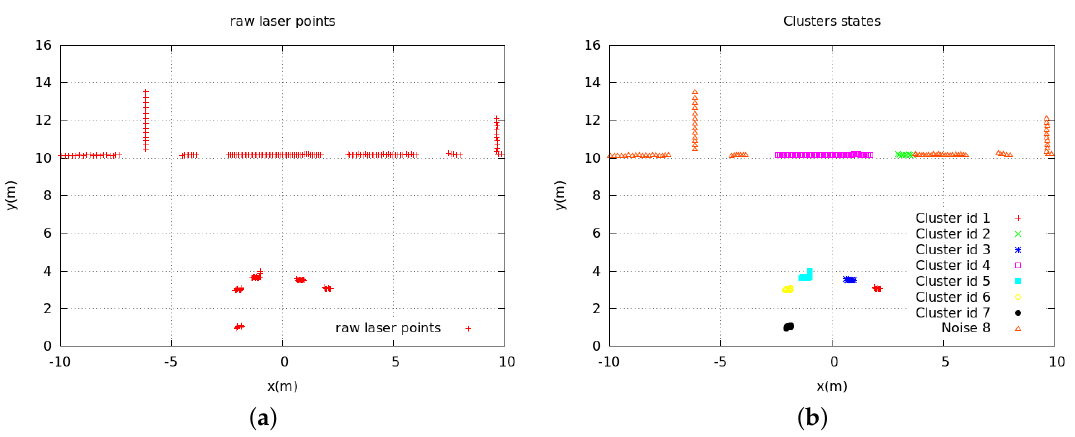
Figure 2. Clustering results. ( a ) raw laser points; ( b ) DBSCAN